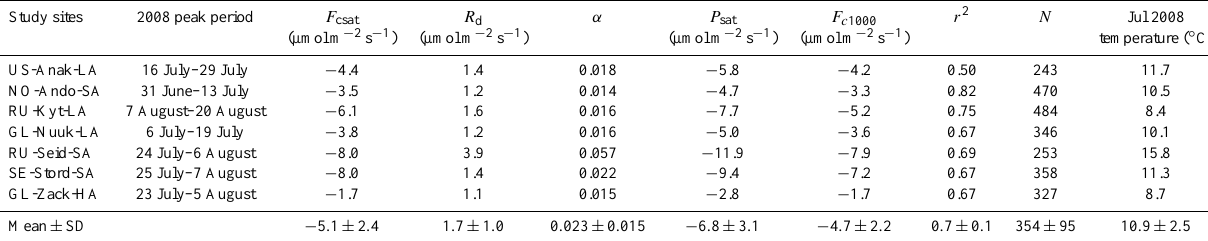
Table A2. Light response curve (LRC) parameters for peak period in